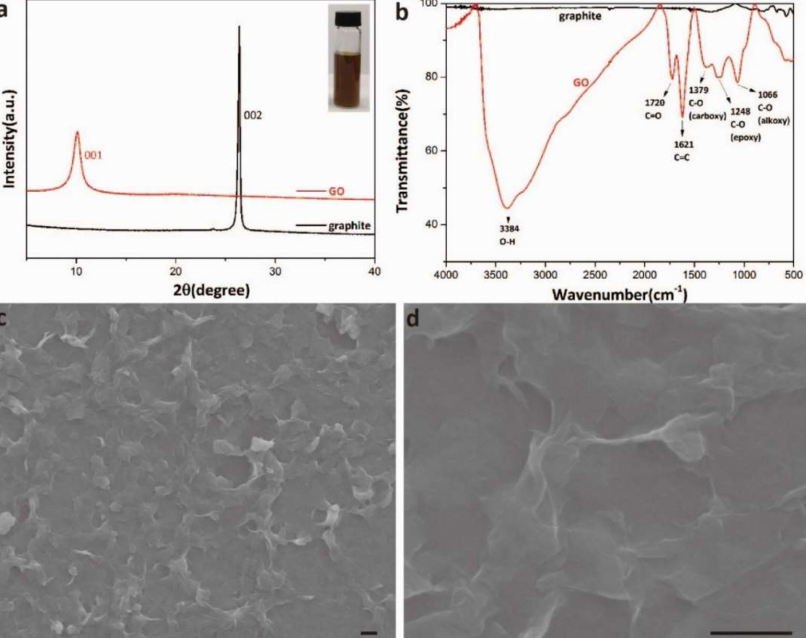
Figure 2. Characterization of the synthesized graphene oxide; ( a ) X-ray diffraction (XRD) image of the graphite (black) and graphene oxide (red). The inset is the optical image of the graphene oxide solution; ( b ) infrared (IR) analysis of the graphite (black) and graphene oxide (red); and ( c , d ) scanning electron microscopy (SEM) images of the graphene oxide. Scale bars: 1 µ